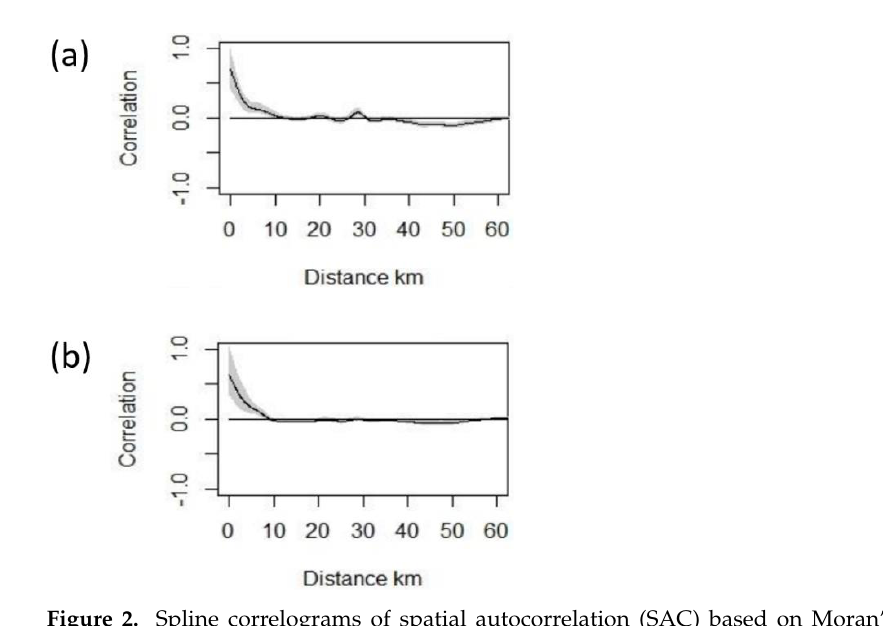
Figure 2. Spline correlograms of spatial autocorrelation (SAC) based on Moran’ I statistic for: ( a ) presence/absence of problematic transmission pylons and ( b ) abundance of problematic nests on transmission pylons, in the provinces of Huelva and Seville (southern Spain) for the period 2015–2019. Moran’s I informs on the distribution pattern of observations and ranges from − 1 (regular) to +1 (complete clustered), with value 0 showing random distribution.